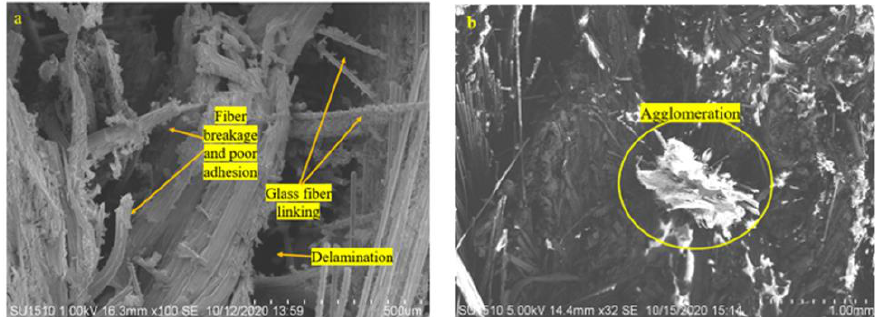
Figure 7: SEM micrographs of fractured tensile samples having 4g-9j-4g stacking sequence with 2% chopped micro- filler: a) Untreated jute and glass (S8); b) Treated jute and glass